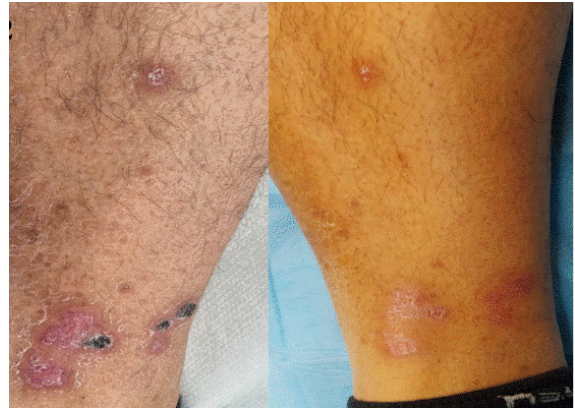
Figure 2. Erythematous–purpuric patches with necrotic foci in a patient with palpable purpura after Pfizer-BioNTech booster almost complete healing 1 month later.